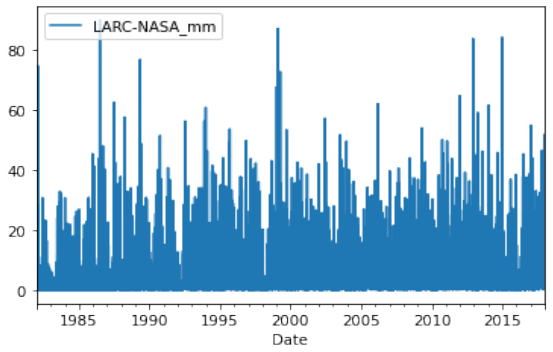
Figure 11. Remote Sensed Data LARC-NASA